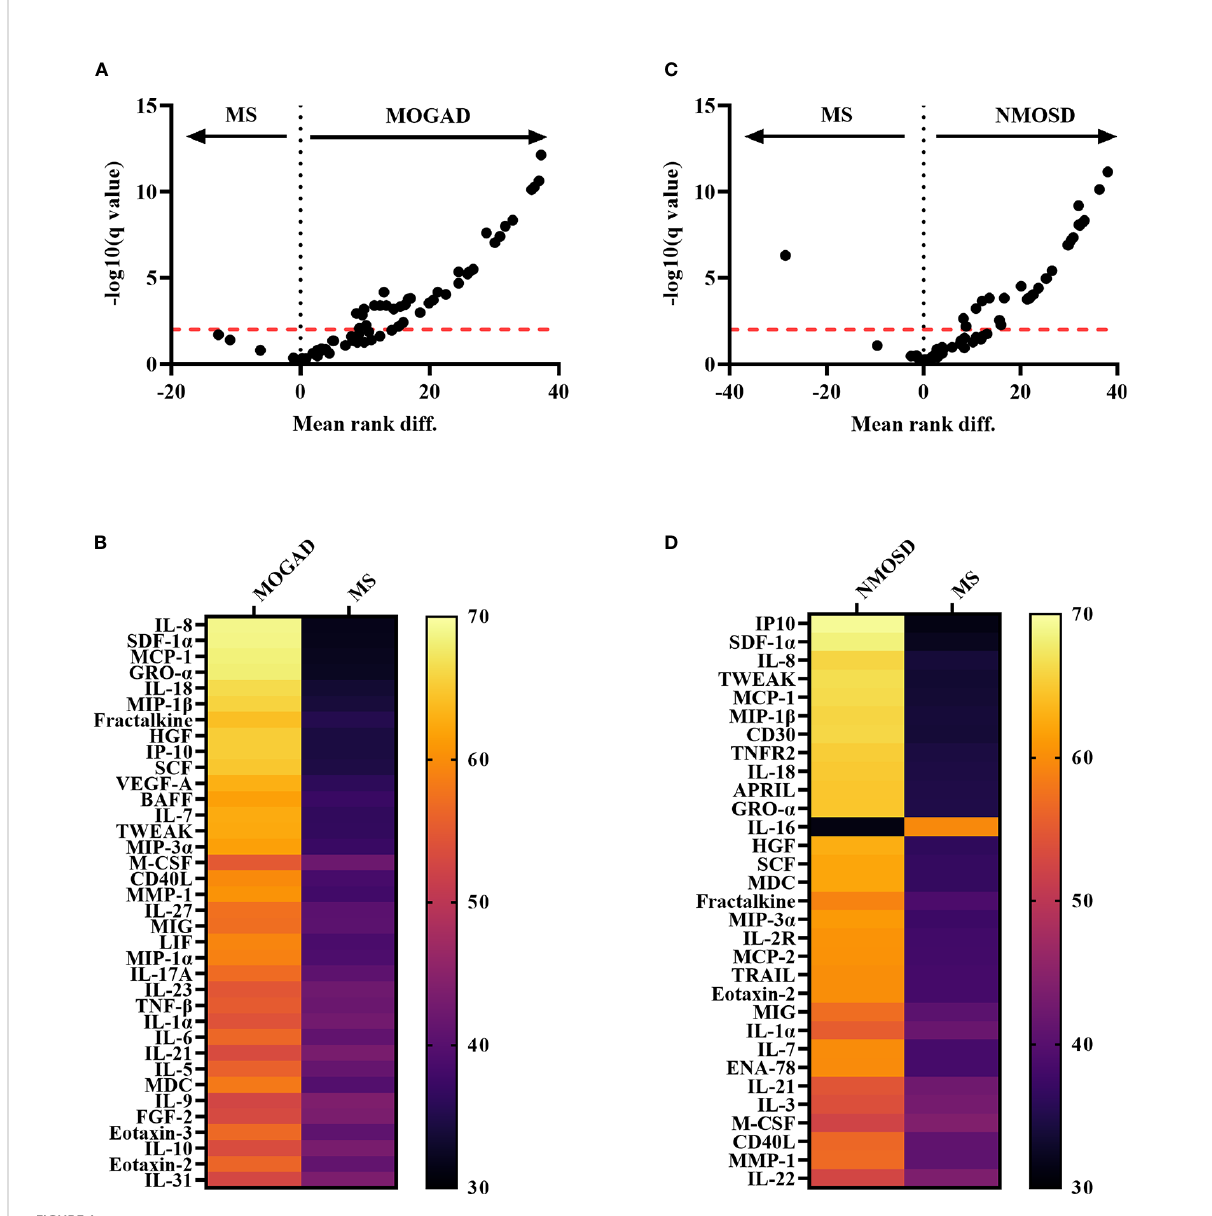
FIGURE 1 Comparison between autoantibody-associated diseases vs MS showing signi fi cantly altered cytokines, chemokines and related molecules. (A) Volcano Plot of Mann-Whitney tests after two-stage step-up (Benjamini, Krieger and Yekutieli) and FDR of 1% correction for multiple comparisons showing comparison of normalized levels (log10-transformation) of 65 cytokines, chemokines and related molecules (bead-based assay 1) between MOGAD and MS patients. The red dotted line indicates the level of signi fi cance after correction for multiple comparisons. Analytes above the red line are classi fi ed as signi fi cantly different between MOGAD and MS. (B) Heatmap showing mean ranks of signi fi cantly different cytokines, chemokines and related molecules comparing MOGAD and MS patients. (C) Volcano Plot of Mann-Whitney tests of 65 cytokines, chemokines and related molecules comparing NMOSD with MS patients after correction for multiple comparisons. Analytes above the red dotted line (level of signi fi cance after correction for multiple comparisons) are classi fi ed as statistically signi fi cant different between the two diseases. (D) Heatmap showing mean ranks of signi fi cantly different cytokines, chemokines and related molecules comparing NMOSD patients with MS patients. APRIL, a proliferation-inducing ligand; BAFF, B cell activation factor; BLC, B lymphocyte chemoattractant; CD40L, CD40 ligand; ENA-78, epithelial neutrophil-activating peptide-78; FGF, fi broblast growth factor; G-CSF, granulocyte colony-stimulating factor; GM-CSF, granulocyte-macrophage colony-stimulating factor; GRO, growth-regulated oncogene; HGF, hepatocyte growth factor; IFN, interferon; IL, interleukin; IP, interferon- ɣ -induced protein; I-TAC, interferon-inducible T cell a -chemoattractant; LIF, leukemia inhibitory factor; MCP, monocyte chemoattractant protein; M-CSF, macrophage colony-stimulating factor; MDC, macrophage-derived chemokine; MIF, macrophage migration inhibitory factor; MIG, monokine induced by interferon- ɣ ; MIP, macrophage in fl ammatory protein; MMP, matrix metalloproteinase; MOGAD, myelin oligodendrocyte glycoprotein associated disease; MS, multiple sclerosis; NGF, nerve growth factor; NMOSD, neuromyelitis optica spectrum disorder; SCF, stem cell factor; SDF, stromal cell-derived factor; TNF, tumor necrosis factor; TRAIL, TNF-related apoptosis-inducing ligand; TSLP, thymic stromal lymphopoietin; TWEAK, tumor necrosis factor-like weak inducer of apoptosis; VEGF, vascular endothelial growth